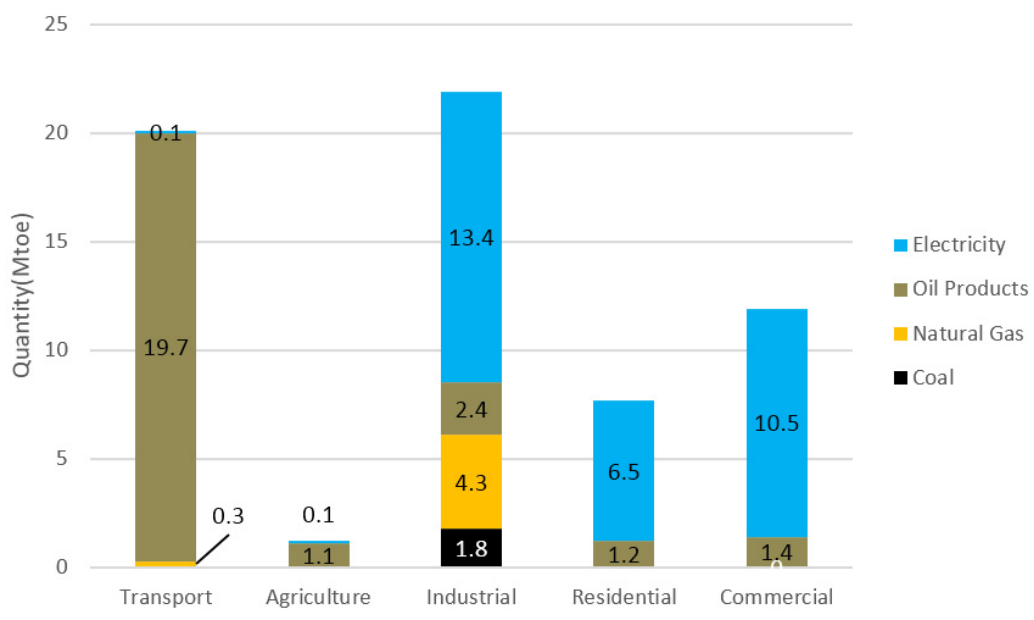
Figure 11. Energy consumption in end-use sectors in Malaysia in